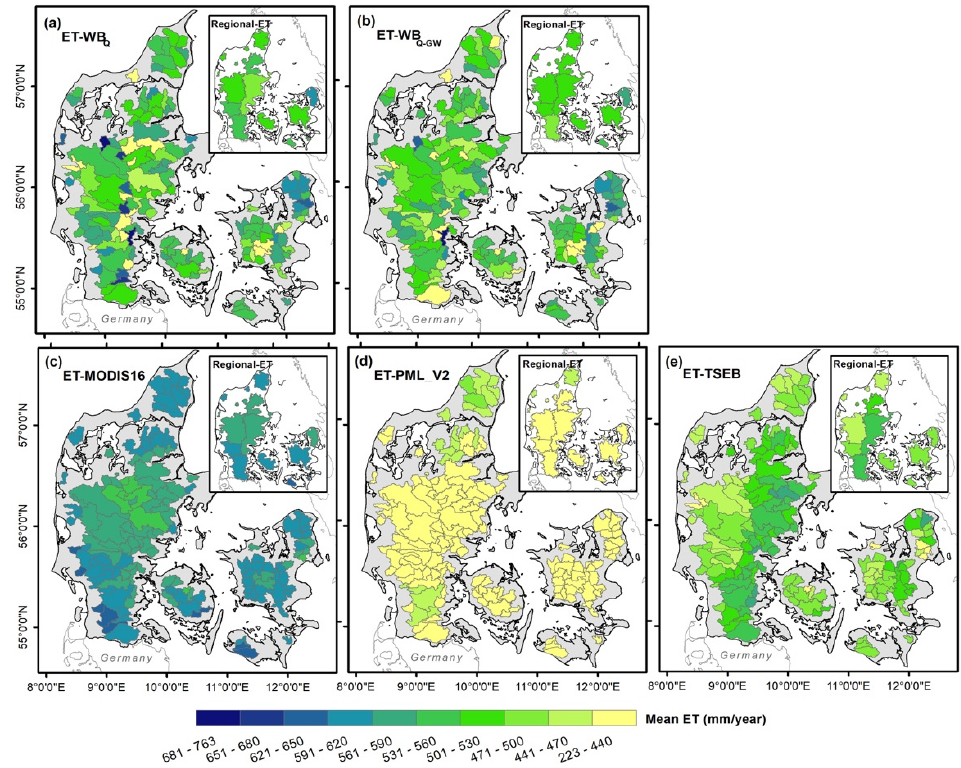
Figure 7. Catchment-based comparison of annual mean ET patterns: ( a ) standard WB ET, ( b ) modified WB ET, ( c ) MODIS16 ET, ( d ) PML_V2 ET, and ( e ) TSEB ET. The small panels indicate aggregated sub-catchments (N = 10 out of 146) for calculation of the regional ET patterns for each ET dataset.